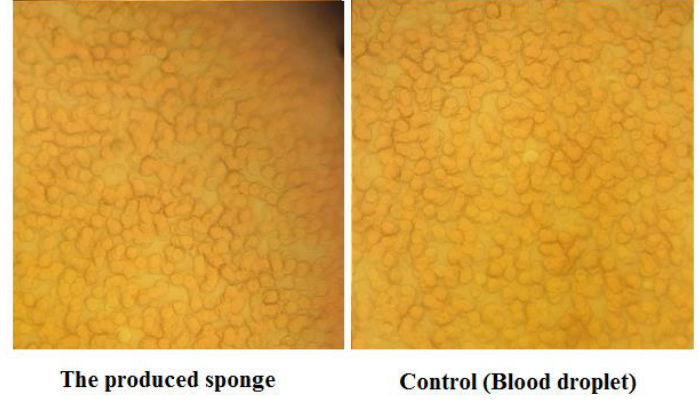
Figure 7. The morphology of RBCs under the light microscope (100×).